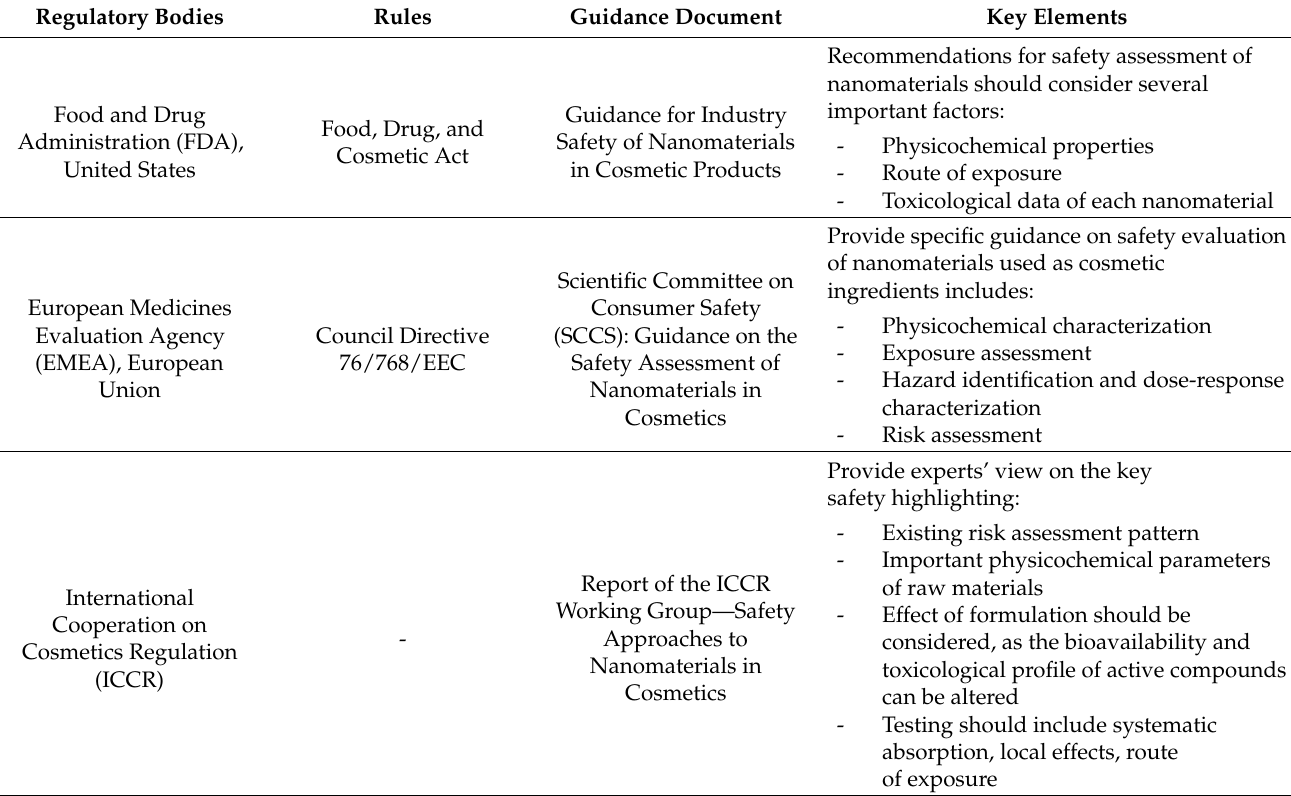
Table 3. Main regulations highlighting the safety of nanomaterial usage in